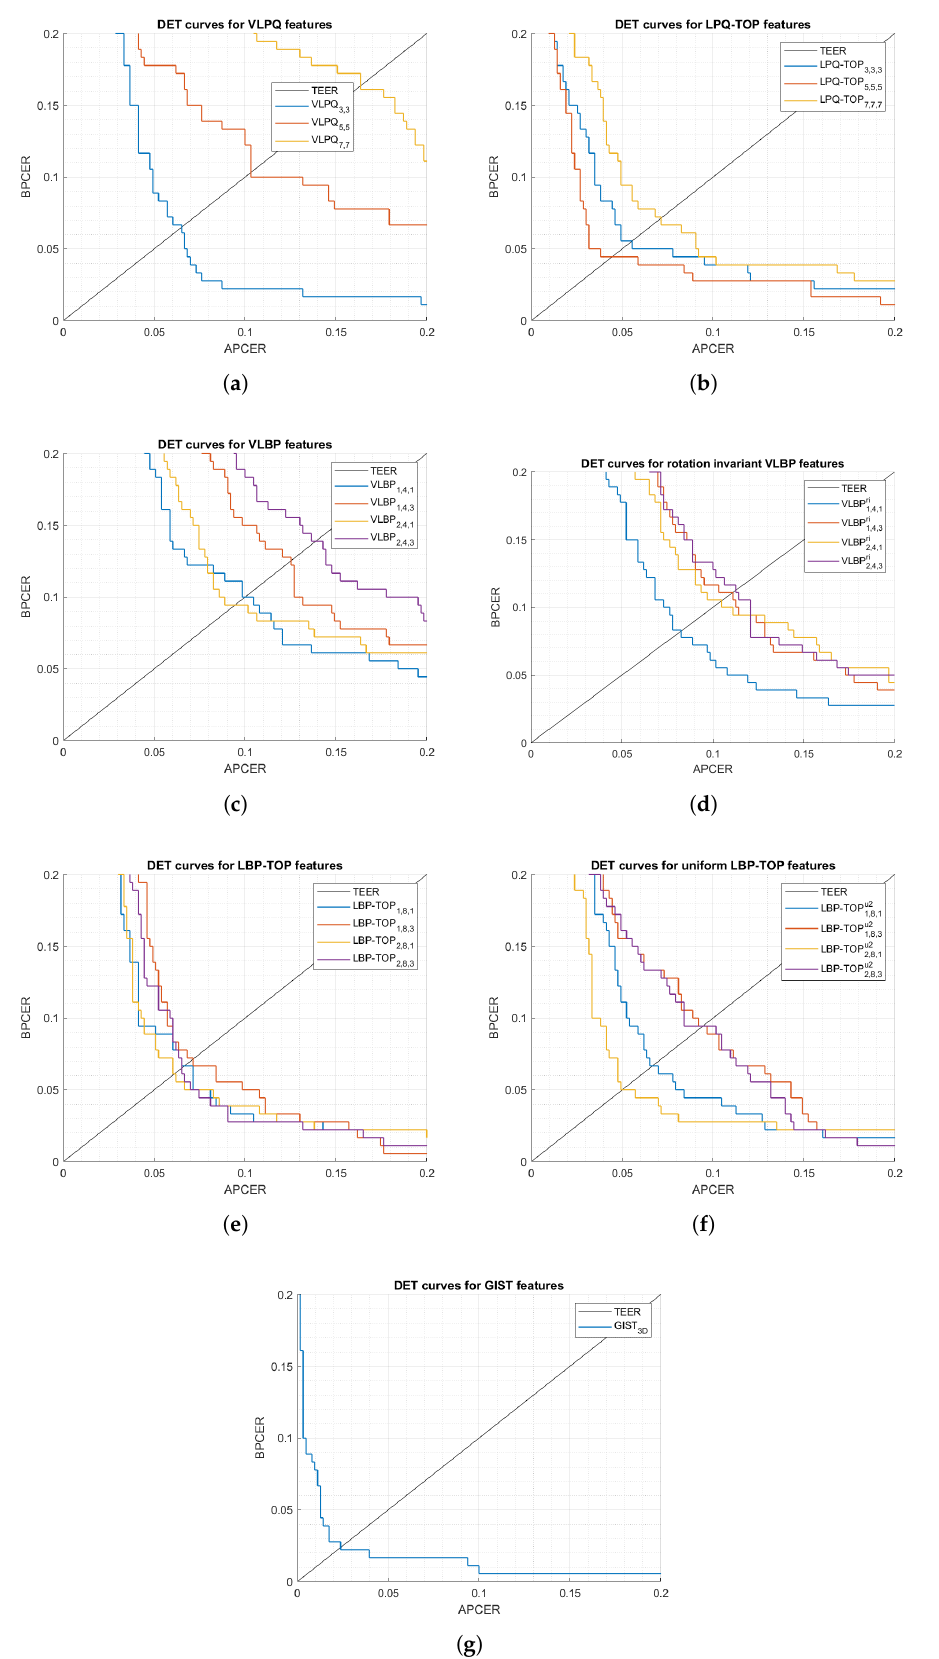
Figure 7. DET curves for the five feature extractors (optical